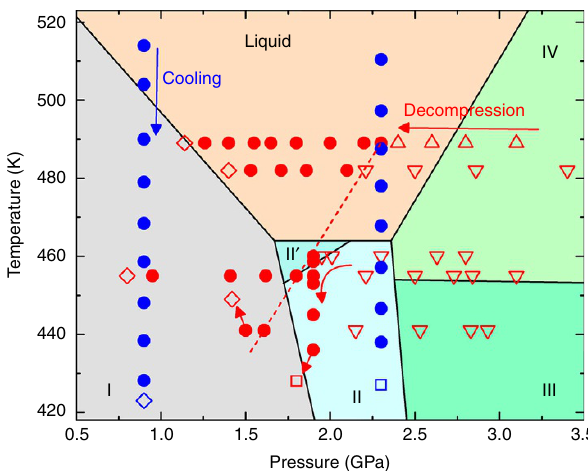
Figure 2 | Experimental conditions where the metastable liquid is observed. Bi-III 0 below 489K is obtained by compressing the DIL at 489K, and then cooled down to lower temperatures. Under decompression (red left arrows) at 489, 482, 460, 455 and 441K, Bi-III 0 (red open down triangles) and Bi-IV (red open up triangles) melt into liquid Bi (red solid circles), followed by crystallization into Bi-I (red open diamonds). Upon compression, transition sequences of Bi-I - II (or II 0 ) - IV (or mixture of IV þ III) are observed (Supplementary Figs 2, 4, 7). Red dash line is a guide for eyes representing the decompression-induced melting line of Bi-III 0 (or IV). At 460K, Bi-III melts into the DIL at 1.9GPa under decompression, and then the DIL is cooled (red down arrow) from 460 to 423K at B 1.8GPa. The DIL crystallizes into Bi-II (red open squares) under cooling at 428K with a slight change in pressure. At 441K, Bi-III 0 melts into liquid Bi at B 1.6GPa. Then the DIL crystallizes into Bi-I upon heating (red up arrow) at 1.5GPa from 441 to 449K. Blue solid circles indicate liquid Bi under cooling (blue down arrow) from equilibrium liquid to supercooled liquid at B 0.9 and 2.2GPa, respectively. The supercooled liquid Bi crystallizes into Bi-I (blue open diamonds) at 0.9GPa 423K and into Bi-II (blue open squares) at 2.2GPa 426K,